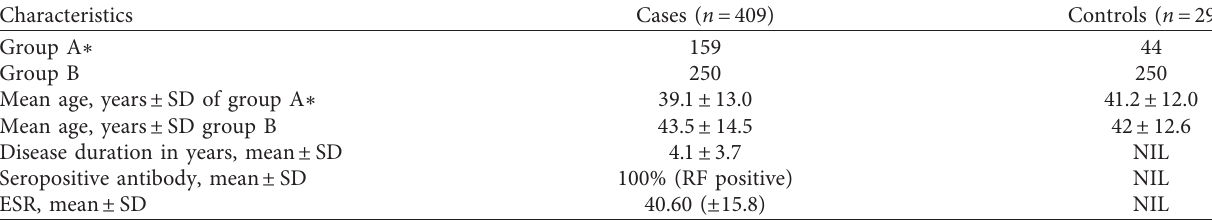
Table 1: Characteristic of rheumatoid arthritis patients and